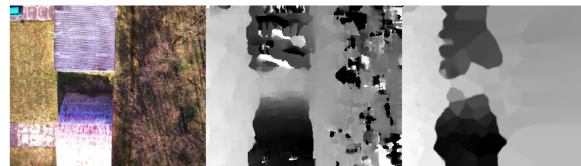
Figure 4. Densification approach: input image (left), plane sweeping (centre), interpolation (right). Image courtesy Kern (2018)